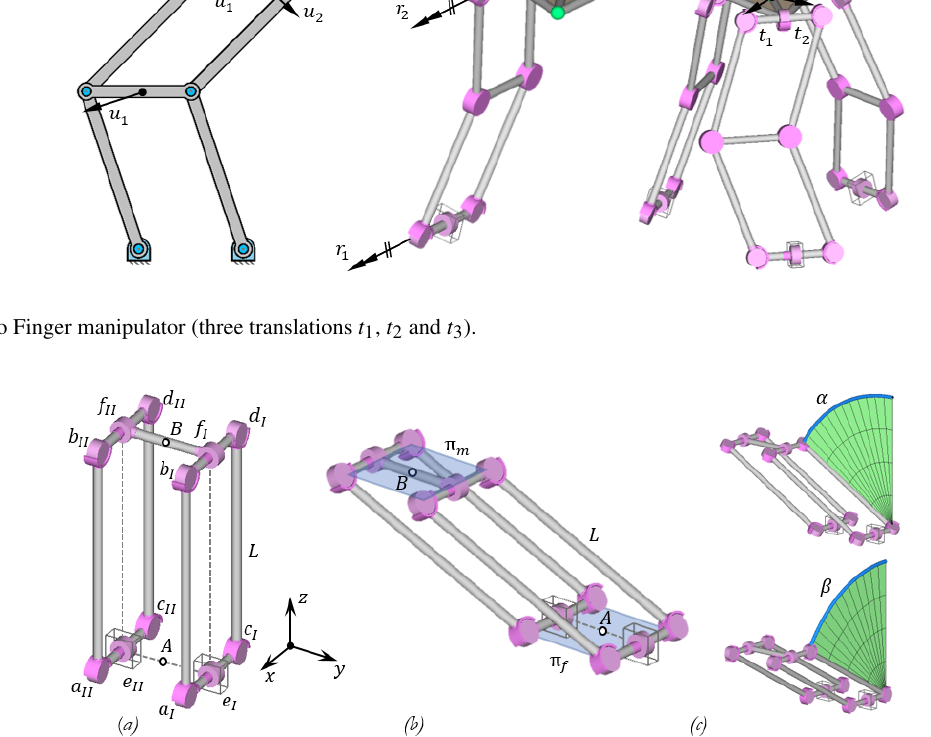
three parallel rotation axes ( r 1 , r 2 , r 3 in Fig. 1) provide the final rotation and the other two